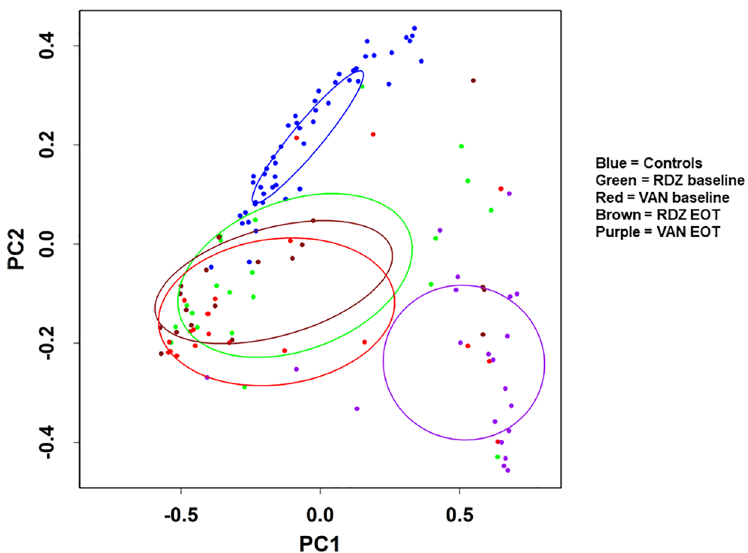
Fig 3. Beta diversity between participants receiving ridinilazole or vancomycin and normal controls. Principal co- ordinate analysis was performed between samples at baseline and EOT from participants receiving ridinilazole or vancomycin in the vegan package in R on weighted Unifrac distances generated in QIIME. For another comparator, healthy controls are also shown. Ellipses represent 95% confidence interval of each cluster. Abbreviations: RDZ, ridinilazole; VAN, vancomycin; PC1, first Principal co-ordinate; PC2, second principal co-ordinate.